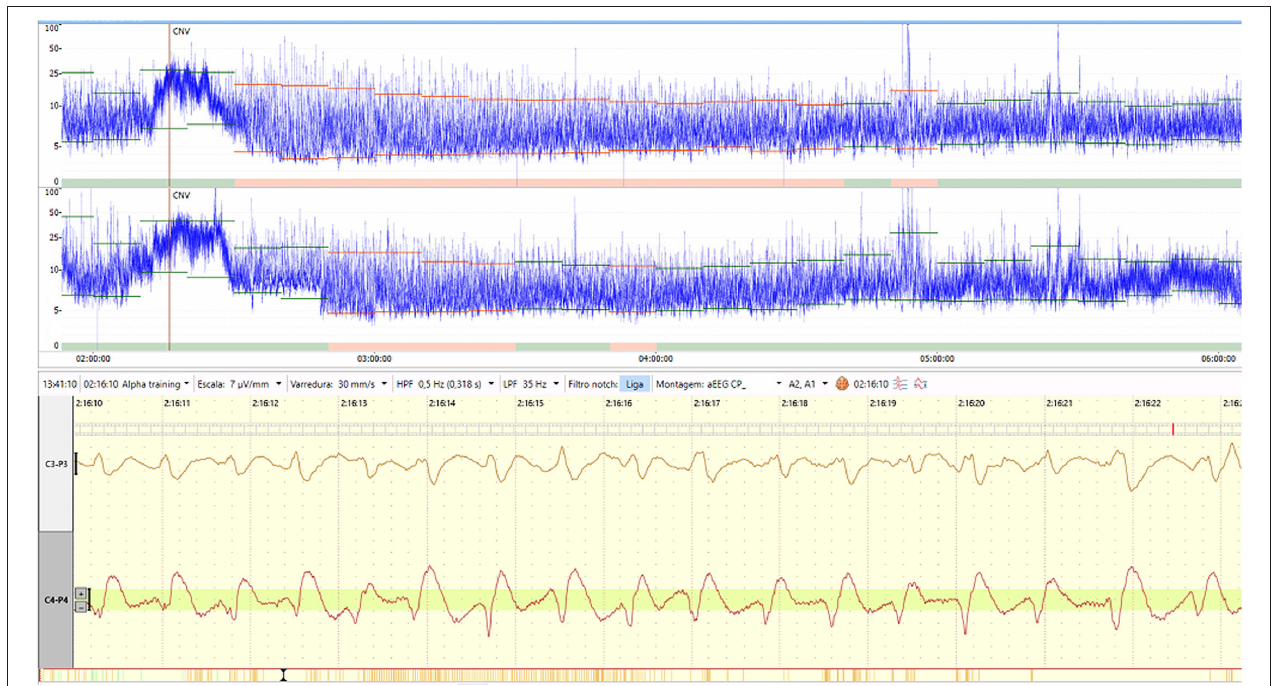
FIGURE 1 | An example of seizures displayed on two-channel aEEG and raw EEG. Figure from the authors’ personal file.